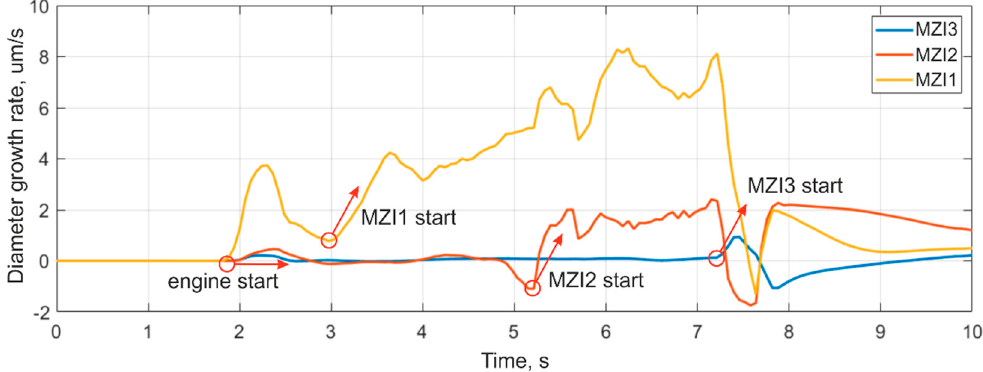
Figure 8. Plots of housing diameter increase.